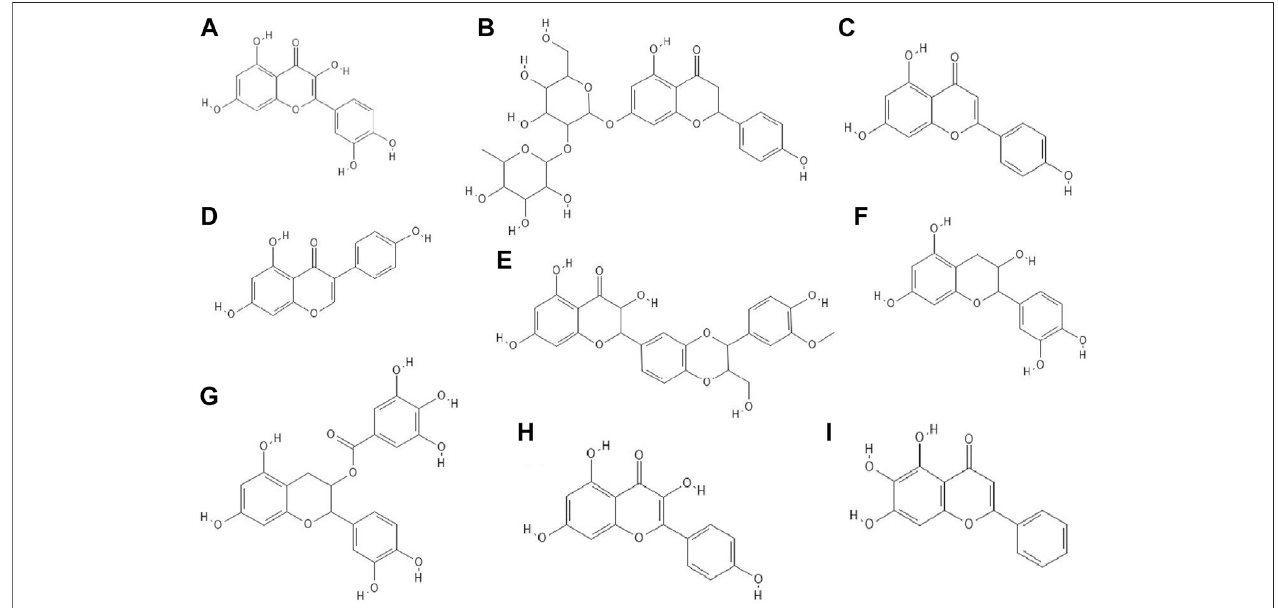
FIGURE 2 | The structures of: quercetin (A) , naringin (B) , apigenin (C) , genistein (D) , silibinin (E) , epicatechin (F) , epicatechin gallate (G) , kaempferol (H) , baicalein (I) .